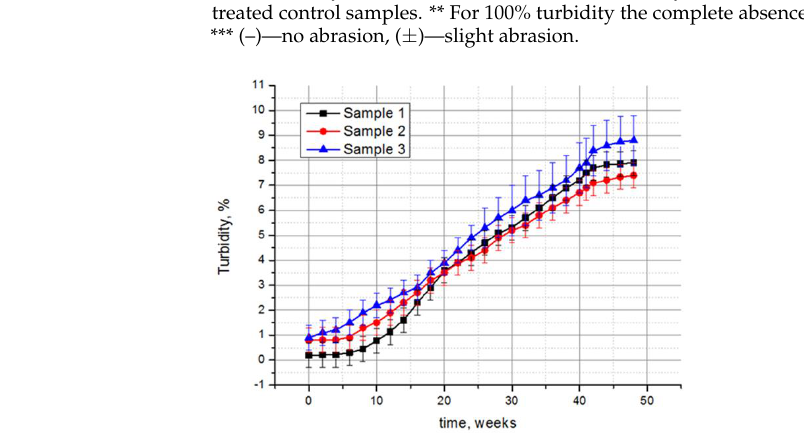
Figure 6. Increase in turbidity of polysiloxane-coated samples during exposure at the Tropical Centre, Vietnam. For 100% turbidity, the complete absence of optical radiation transmittance was taken. Average data of three independent experiments with standard deviation are presented.